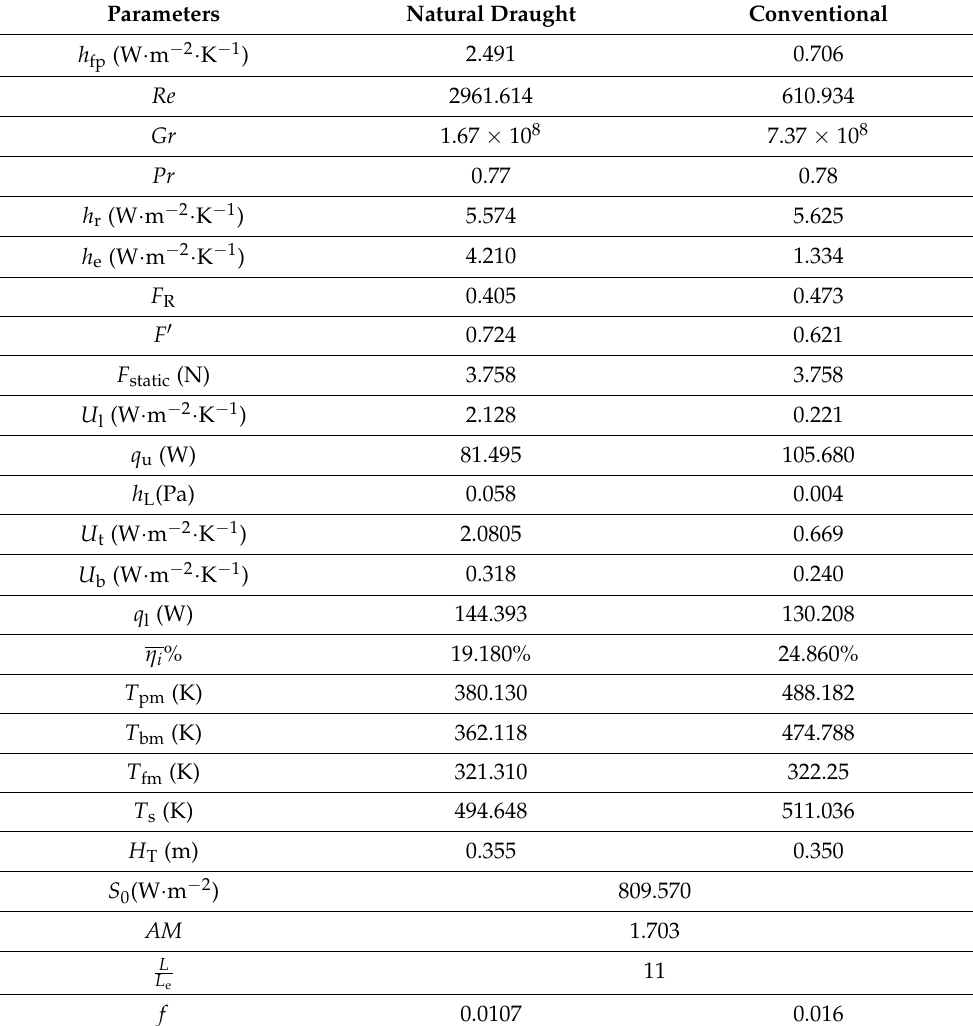
Table 3. Parametric information related to the performance of a solar collector, based on average values.